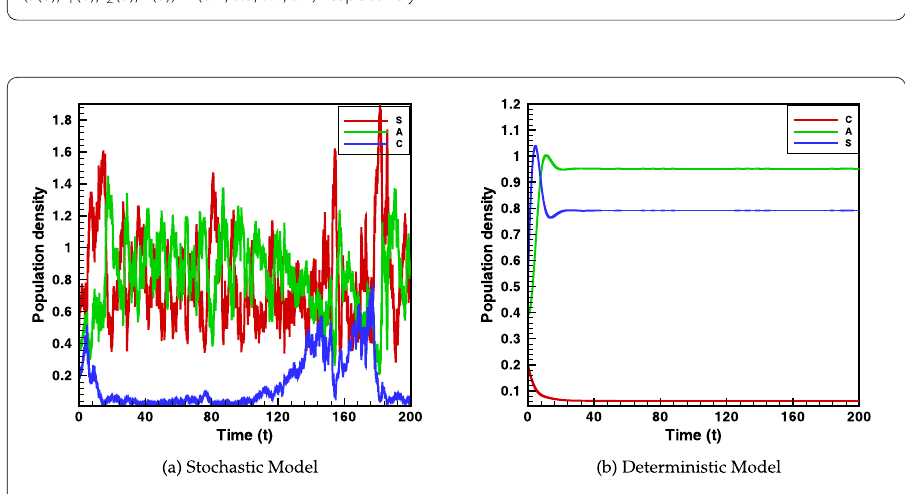
Figure 2 Simulation of system (3) with time step and initial size of the population (cid:11) t = 0.01 and ( S (0), I 1 (0), I 2 (0), R (0)) = (0.7,0.6,0.4,0.2)